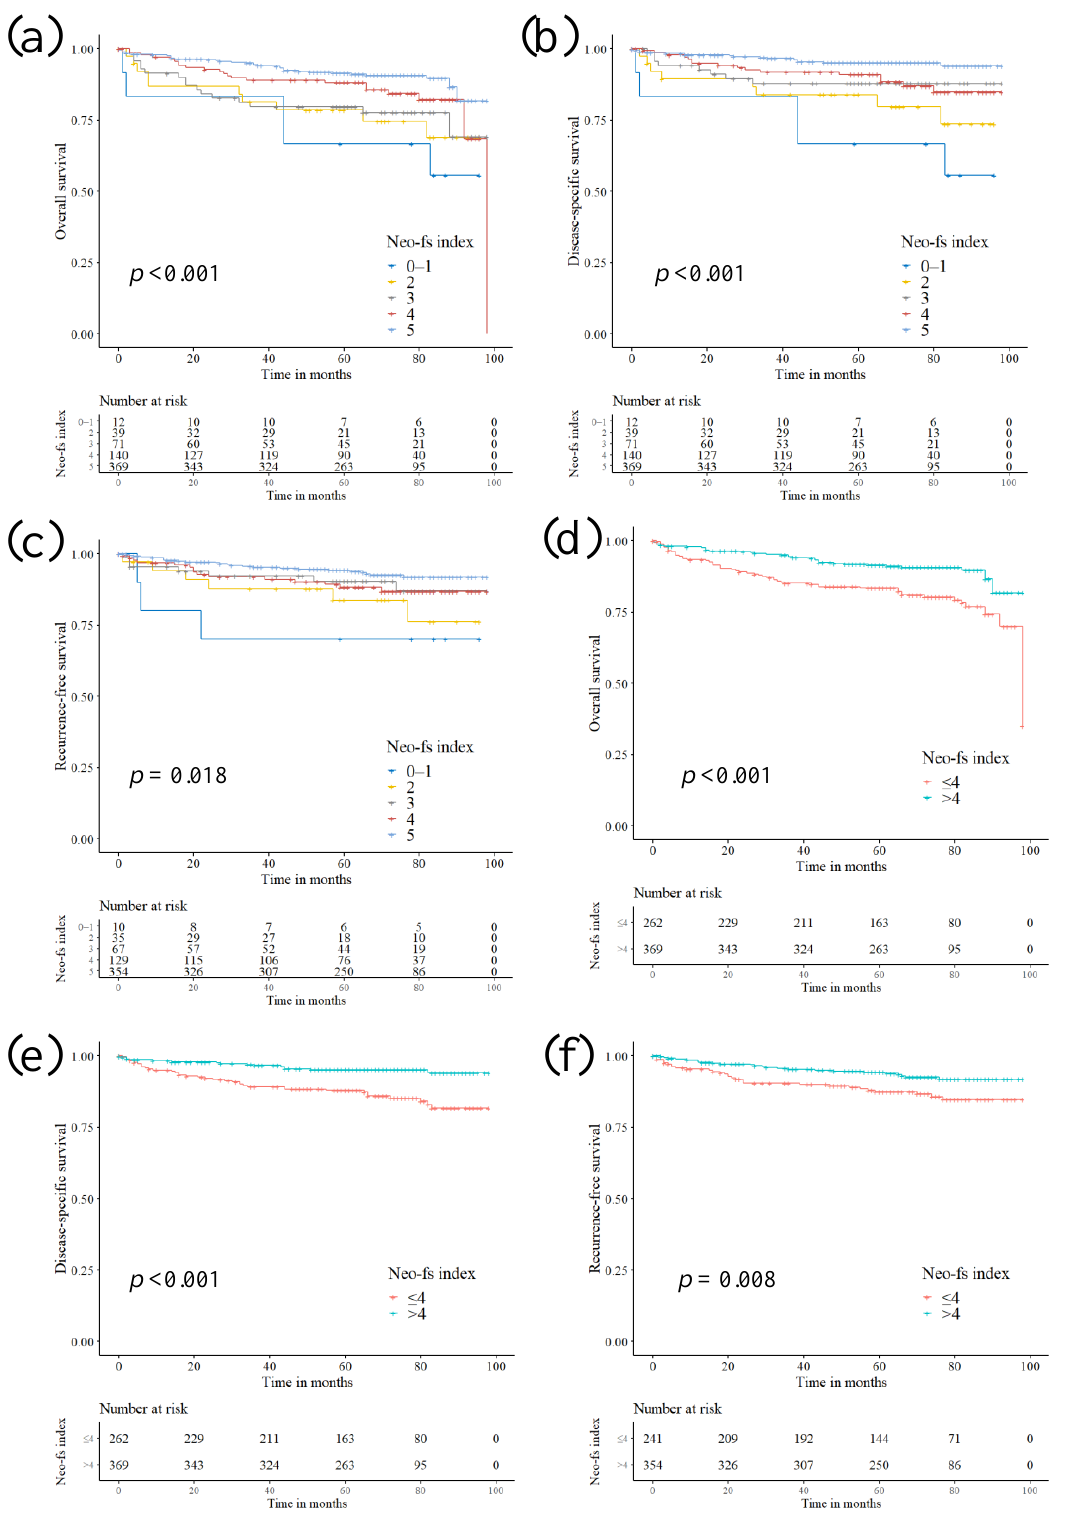
Figure 1. Kaplan‒Meier survival curves for patients with clear cell renal cell carcinoma based on the immunohistochemistry-based Neo-fs index. Neo-fs index—the number of highly expressed protein markers among APC, NOTCH1, ARID1A, EYS, and filamin A—demonstrated a cumulative favorable effect on overall survival (OS) ( p < 0.001) ( a ), disease-specific survival (DSS) ( p < 0.001) ( b ), and recurrence-free survival (RFS) ( p = 0.018) ( c ) in patients with clear cell renal cell carcinoma. When stratified into Neo-fs index >4 and ≤ 4, Neo-fs index >4 was associated with favorable OS ( p < 0.001) ( d ), DSS ( p < 0.001) ( e ), and RFS ( p = 0.008) ( f